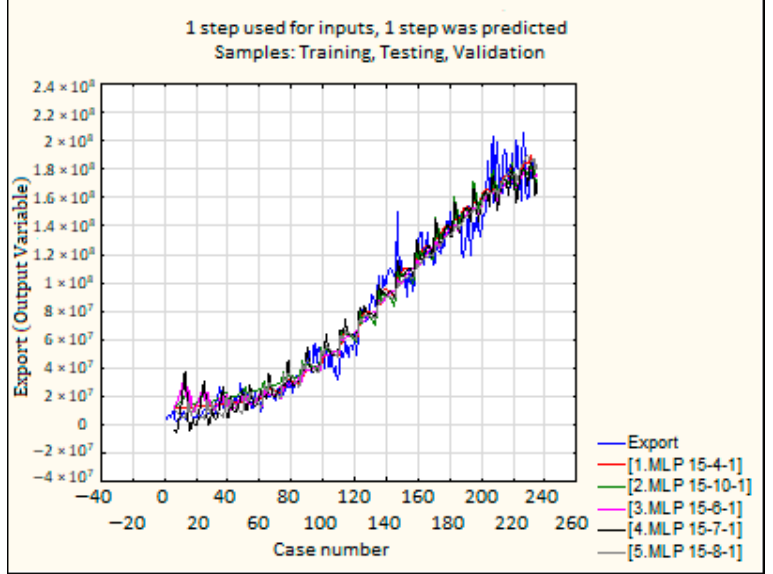
Figure 4. Equalized time series for retained networks (Experiment 2) . Source: Authors.